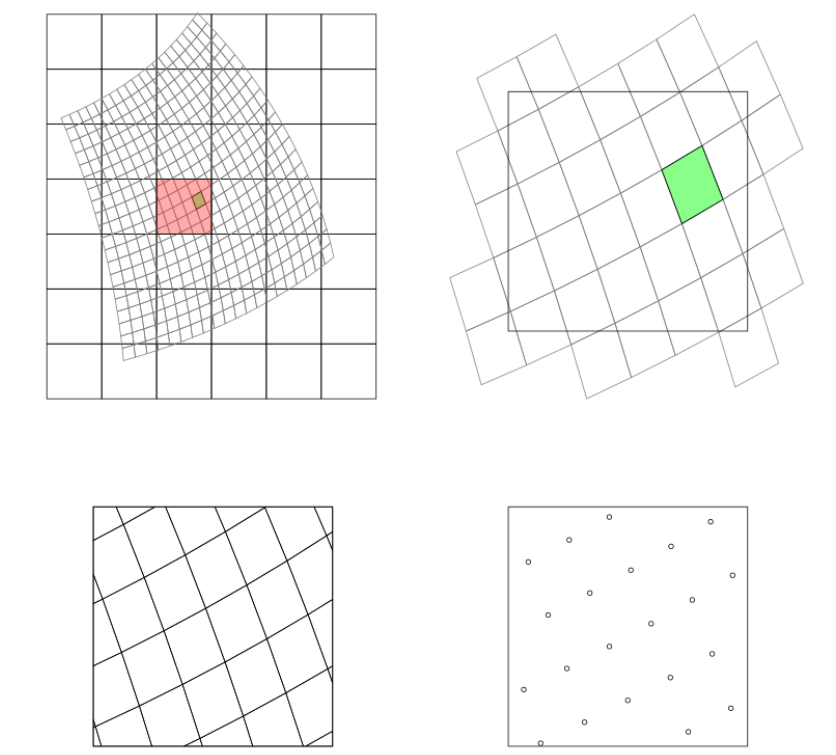
Figure 3. Regridding: original values are available for the grid indicated by grey lines, new values are required for the black lined grid (e.g., the red cell), or vice versa (e.g., the green cell). New cell values can be calculated from the intersecting grid areas (lower left), intersecting grid cell centre points (lower right), or using interpolation (e.g., from black cells or cell center points to the green